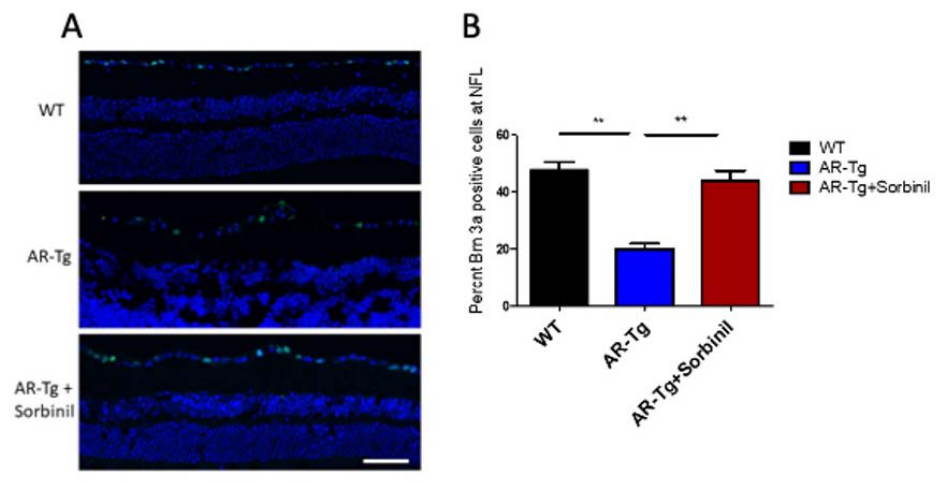
Figure 4. Abundance of Brn3a-positive ganglion cells. ( A ) Immunofluorescence staining for Brn3a (green) in nontransgenic control (WT) and AR-Tg mice as well as AR-Tg mice treated with Sorbinil. Mice were 24 weeks of age. Cell nuclei were visualized with DAPI staining (blue). Scale bar = 50 µ m. ( B ) Quantitation of Brn3a-positive cells. Brn3a-positivity was assessed by counting ≥ 3 fields from ≥ 3 animals from each group. ** p < 0.01.